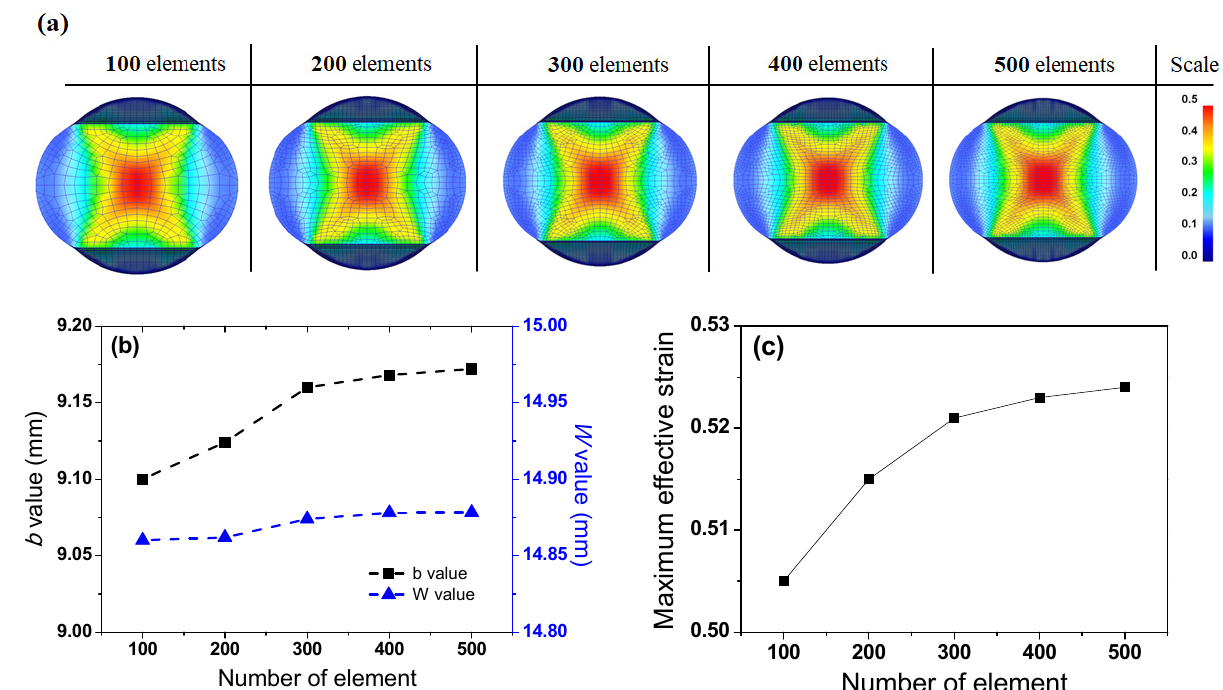
Figure 3. Comparison of ( a ) effective strain contours, ( b ) W and b , and ( c ) ε max of the wire with the number of elements at a roll diameter of 400 mm.